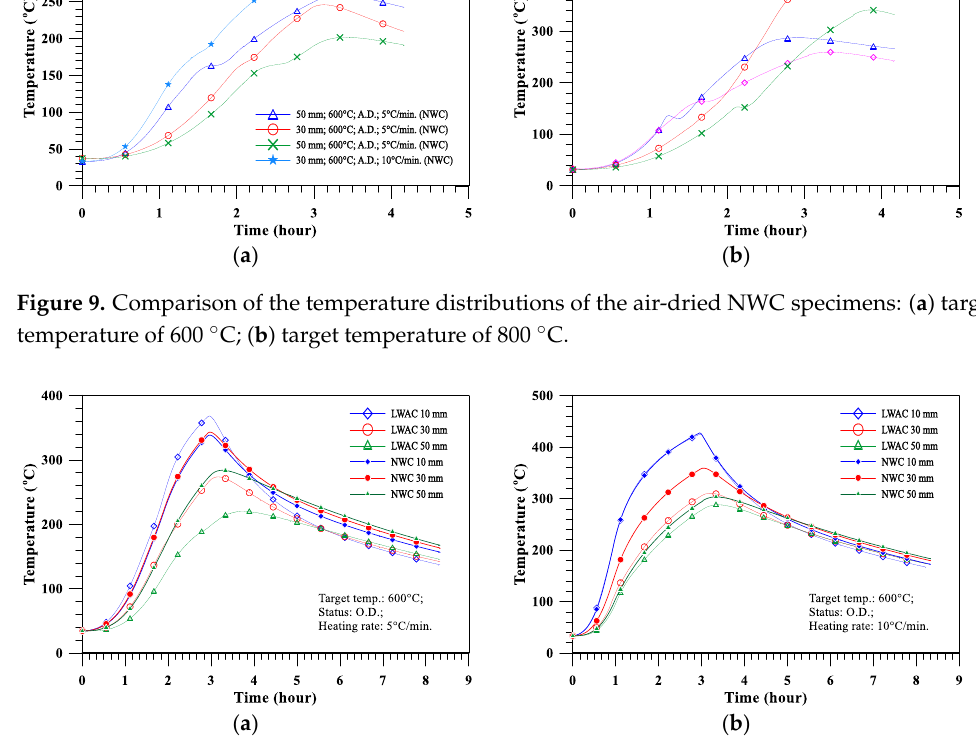
Figure 10. Comparison of the temperature distribution between the LWAC and NWC oven-dried specimens at a target temperature of 600 °C: ( a ) heating rate of 5 °C/min; ( b ) heating rate of 10 °C/min.